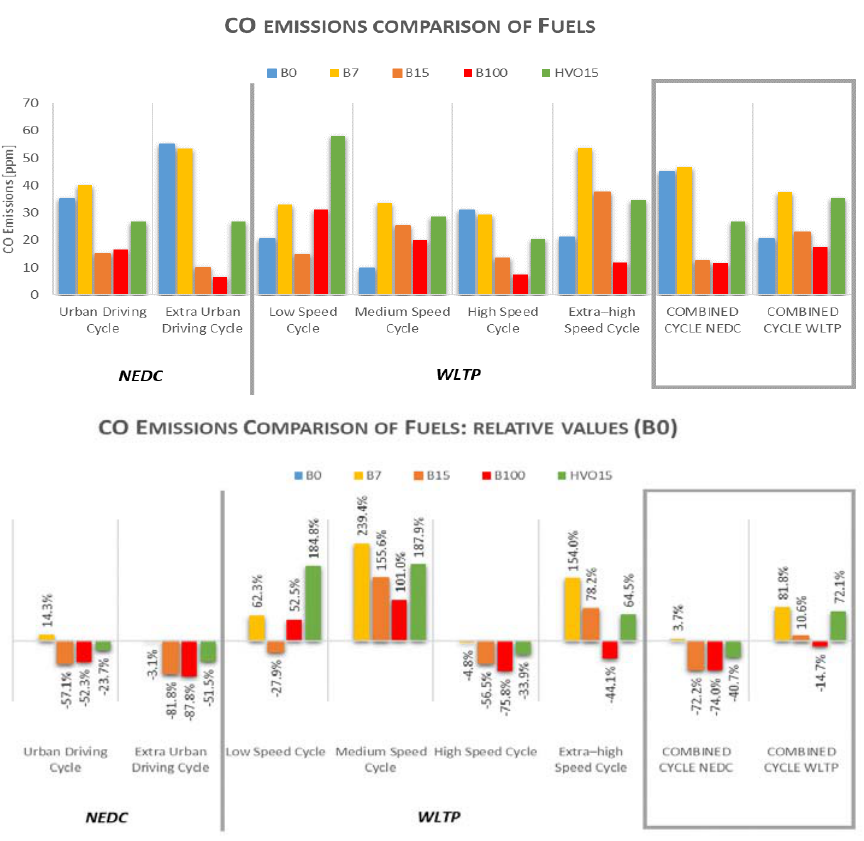
Figure 3. CO emissions comparison of fuels, in total value and in percentage differences, in relation to the B0 fuel.